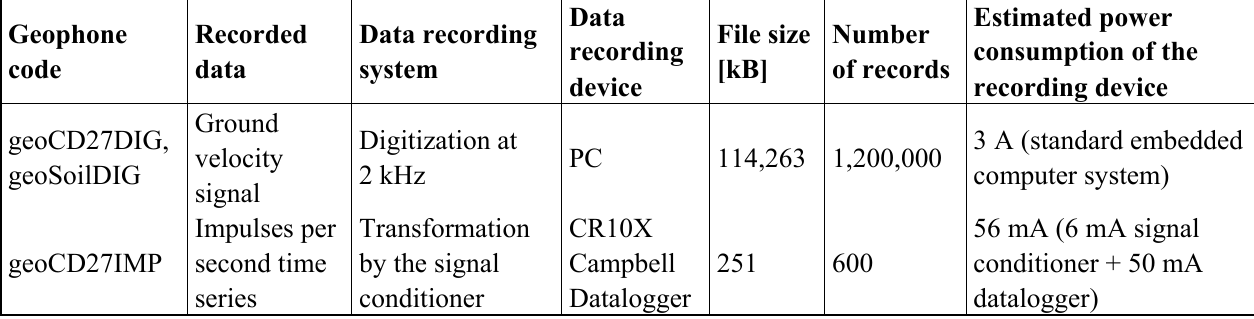
Table 2. Details of the data recording systems of the three geophones in Illgraben with regards to the event of 27 July